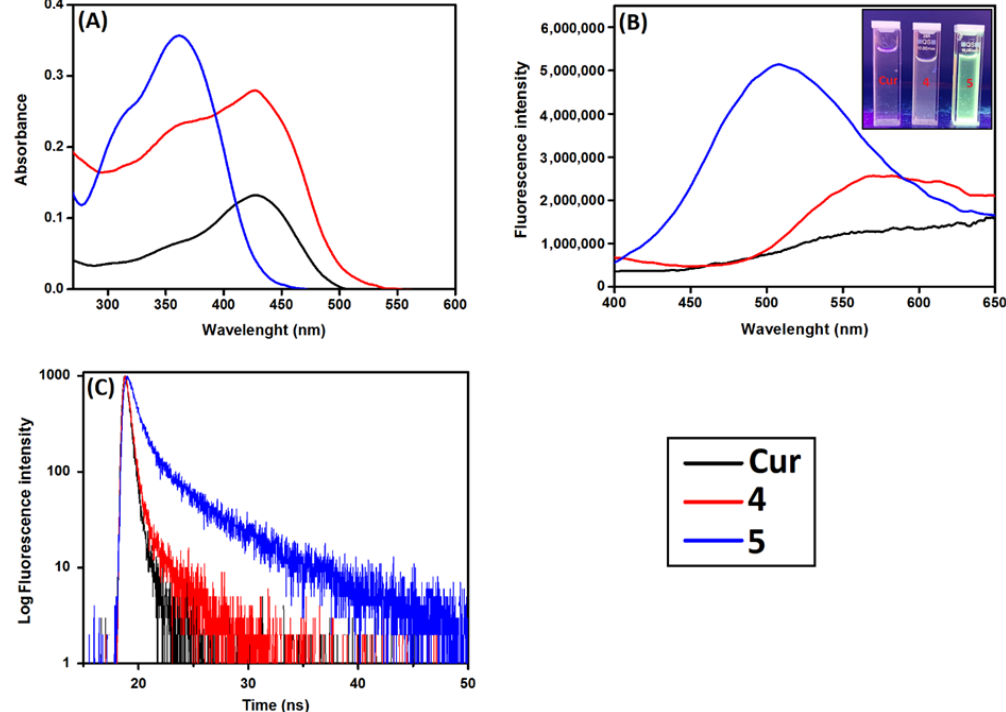
Figure 4. Photophysical properties of Cur, β -CD@Cur 4 and ( β -CD) 2 @Cur 5 in D 2 O at room temperature. ( A ) UV–vis absorption spectra at a single concentration of Cur (c = 12 µ M), and ( B ) fluorescence emission and ( C ) fluorescence lifetime spectra at λ exc = 360 nm (A 360 nm = 0.2).